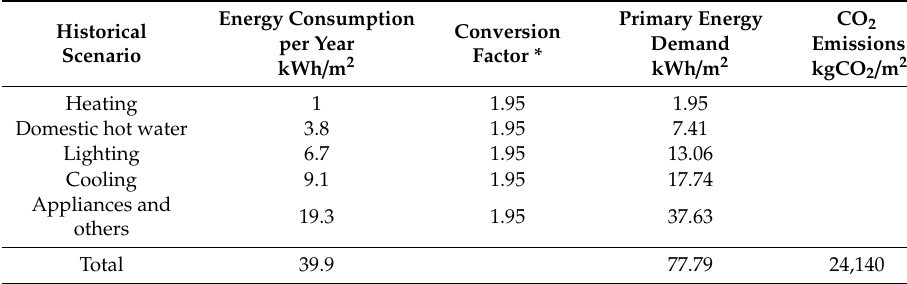
Table 2. Summary of energy consumption in the historical scenario.